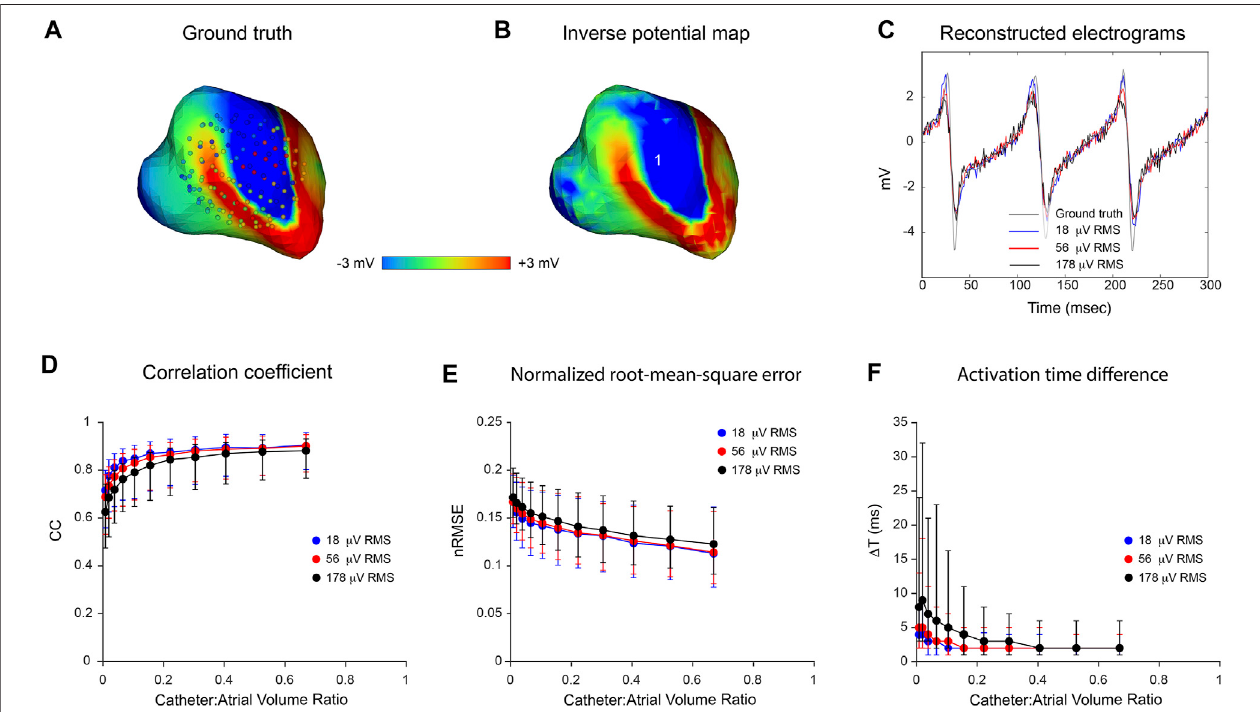
FIGURE 5 | Effects of catheter dimension and noise on inverse potential maps reconstructed during macro-reentry using FEM. LA surface potentials during 3 cycles ofsimulated atrial fl utterare reconstructedfrom electrogramssampled inside theLA cavity with130-electrode basket catheters and compared withground-truth data. The upper panel presents typical results for catheters that bound a volume fraction of 0.67 relative to LA volume. These include (A) the ground-truth surface potential distribution at one instant with catheter electrodes overlaid (B) corresponding potential map reconstructed using electrograms “ sampled ” with a 130- electrode basket catheter, and (C) electrograms reconstructed at location 1 from sampled records with 18 µV RMS (blue), 56 µV RMS (red) and 178 µV RMS (black) of added Gaussian noise compared with the ground truth electrogram (grey) at thesamesite. In the lower panel, (D) correlation coef fi cient (CC) (E) normalized root-mean- squarederror(nRMSE),and (F) activationtimedifference( Δ T)arepresentedasfunctionsofcatheter-atrialvolumeratiofortheselevelsofaddednoise.Medianvaluesand interquartile range are given. Abbreviation: FEM, fi nite element